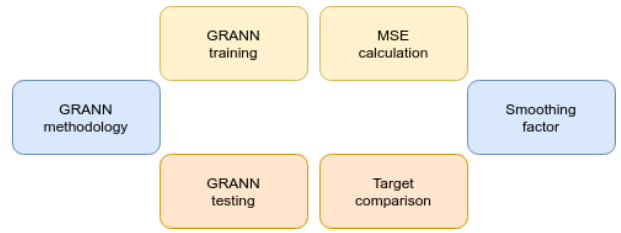
Figure 4. GRANN training and determination of the smoothing factor